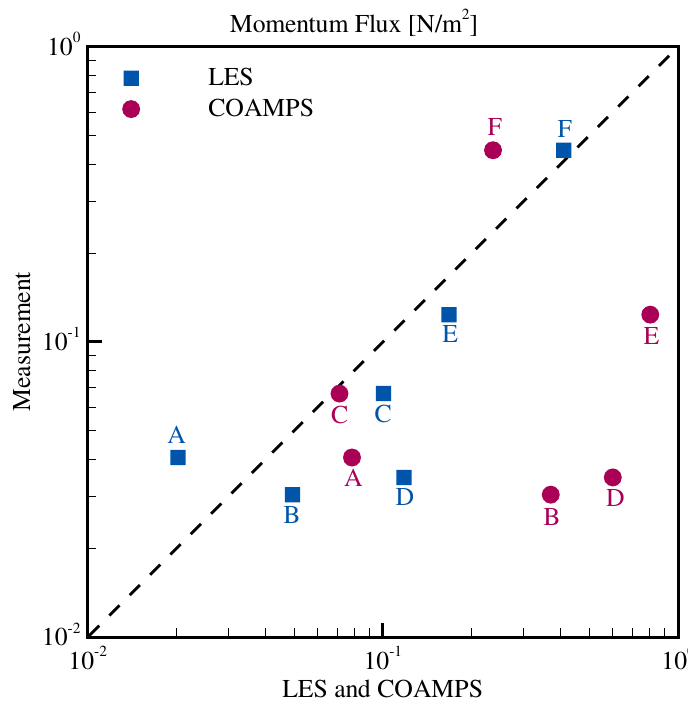
Figure 5. Turbulence momentum flux ρ u (cid:48) w (cid:48) obtained from LES and COAMPS (Coupled Ocean/Atmosphere Mesoscale Prediction System) versus field measurement results at locations A and B in case ESB1, C, D and E in case MAB, and F in case DMB. See Figure 1 for locations